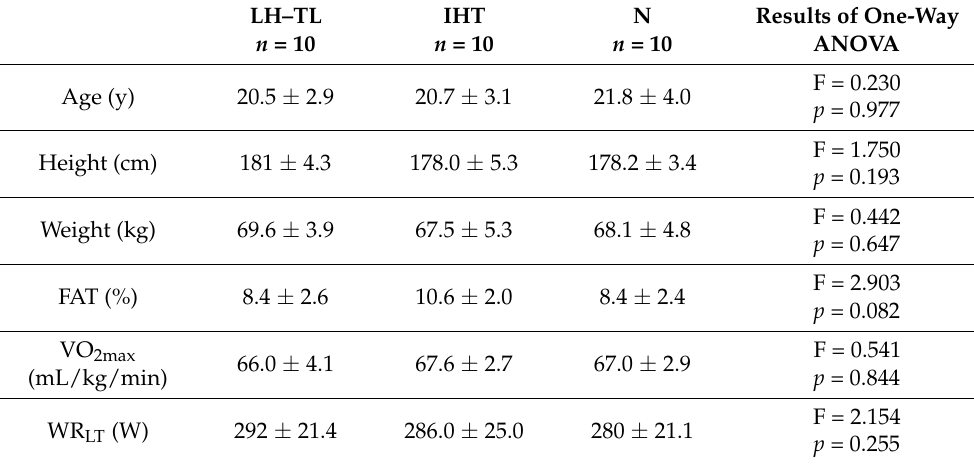
Table 1. Characteristics of the study participants (mean ± SD).